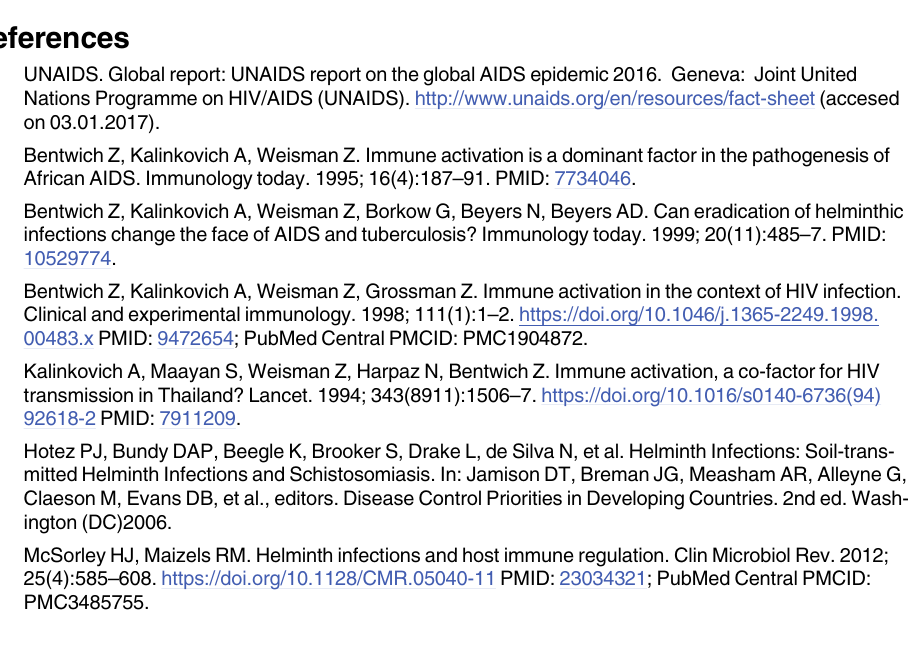
S8 Table. Association of various factors with mean fluorescence intensity of CCR5 on memory CD4 T cells (N = 216; Mean = 785). Uni- and multi-variable mixed-effects linear regression results, with random effect for residence in Kyela site, multivariable models addi- tionally adjusted for age, gender and fever during last 24 hours and different helminth infec-